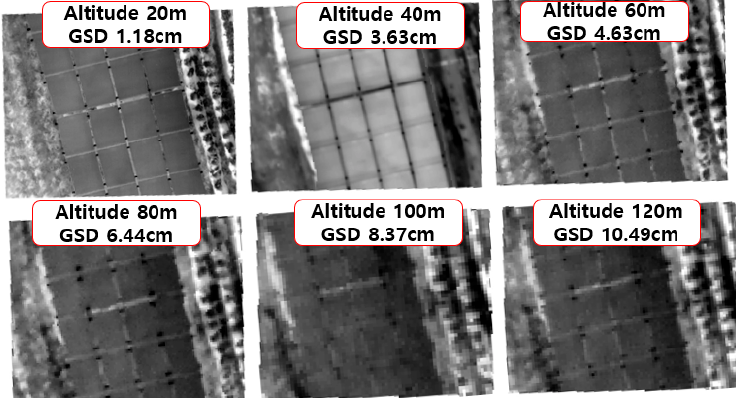
Figure 4. Spatial resolution of thermal infrared images taken by incrementally changing the UAV altitude by 10 m.